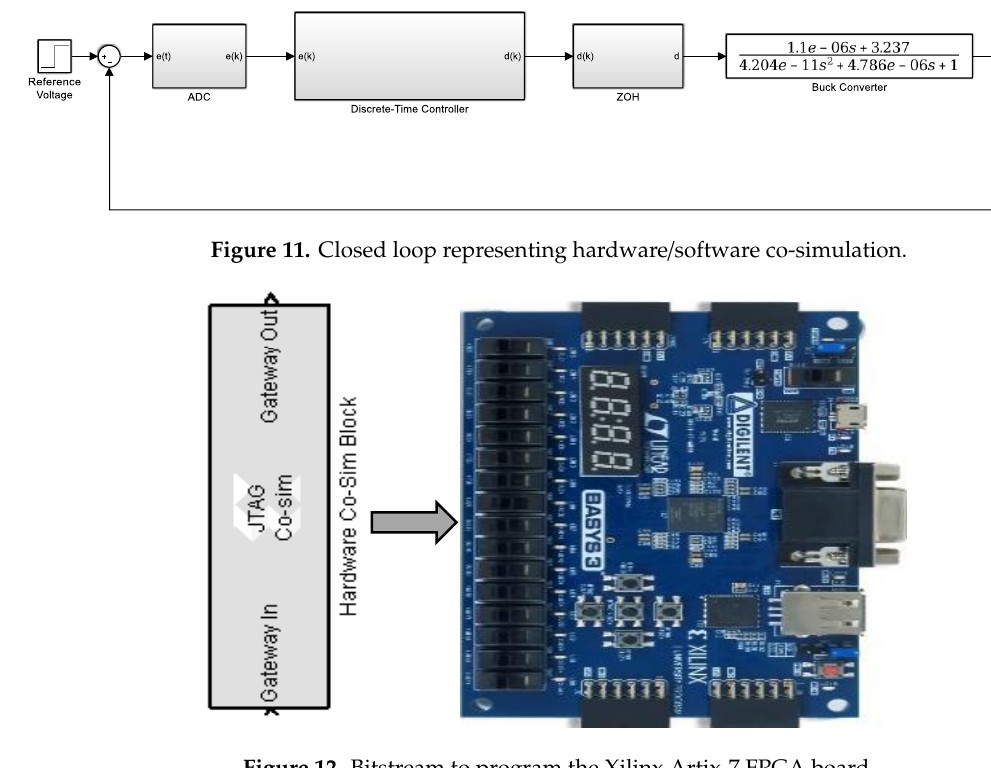
Figure 11. Closed loop representing hardware/software co-simulation.